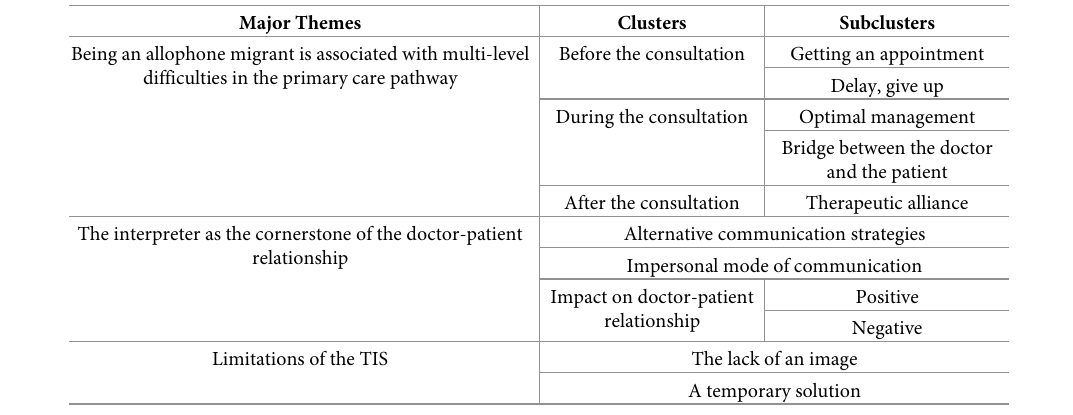
Table 2. Summary of the themes derived from the interviews and clustering of the allophone migrants’ perception of the TIS.